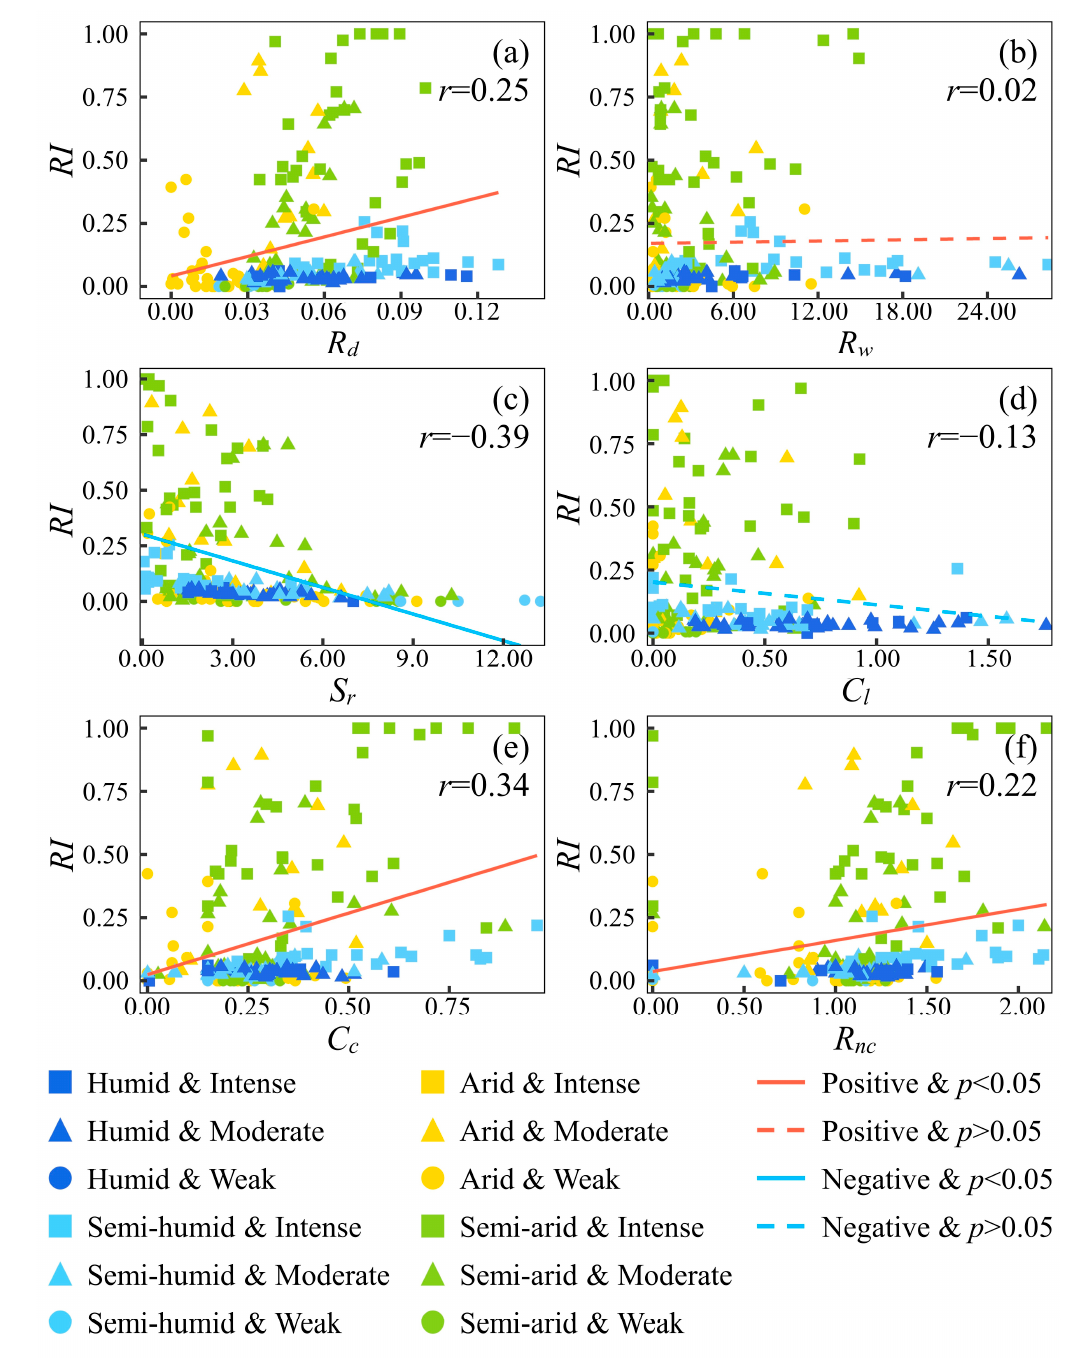
Figure 5. Plots illustrating the correlation between WER and SCCs in China. The subplots ( a )–( f ) showed correlations between RI and R d , RI and R w , RI and S r , RI and C l , RI and C c , RI and R nc , respectively.